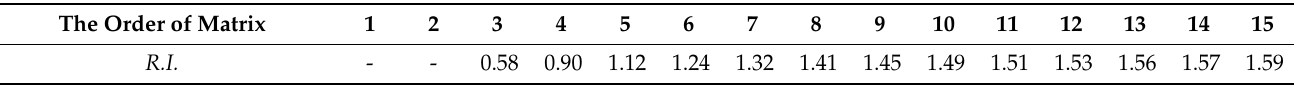
Table 2. Random indexes ( R.I.